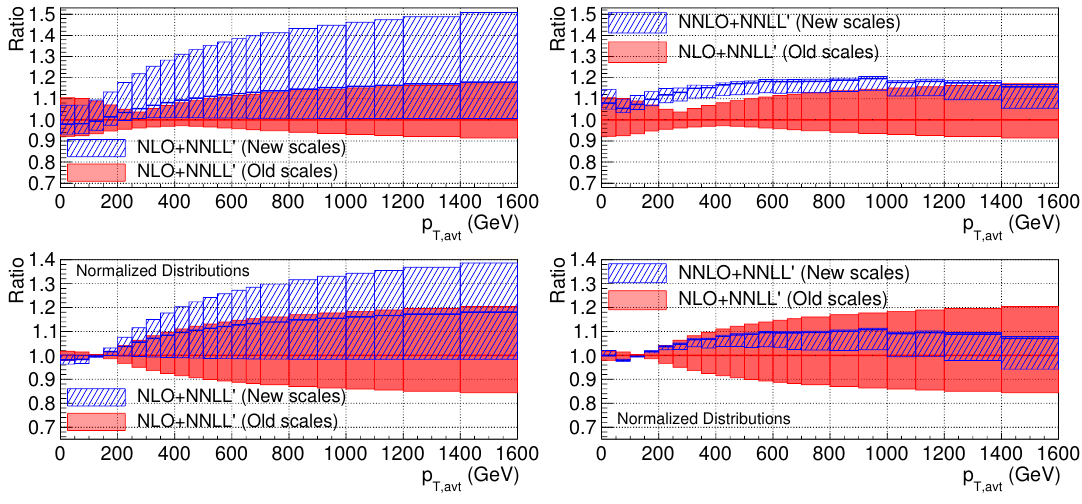
Figure 11 . Same as (cid:12)gure 10 but for the p T; avt